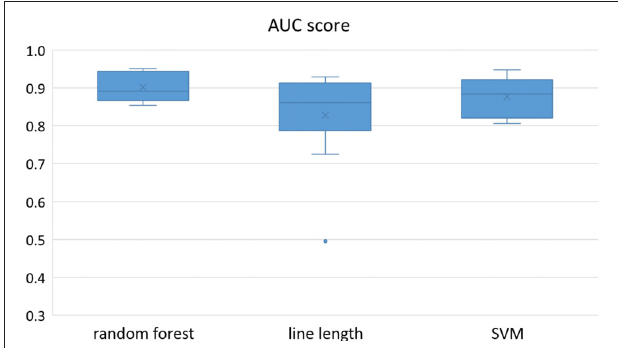
FIGURE 1 | Detection performance of the classifiers over all the patients based on a best channel (highest area under the receiver operating characteristic (ROC) curve (AUC)) selection per patient.